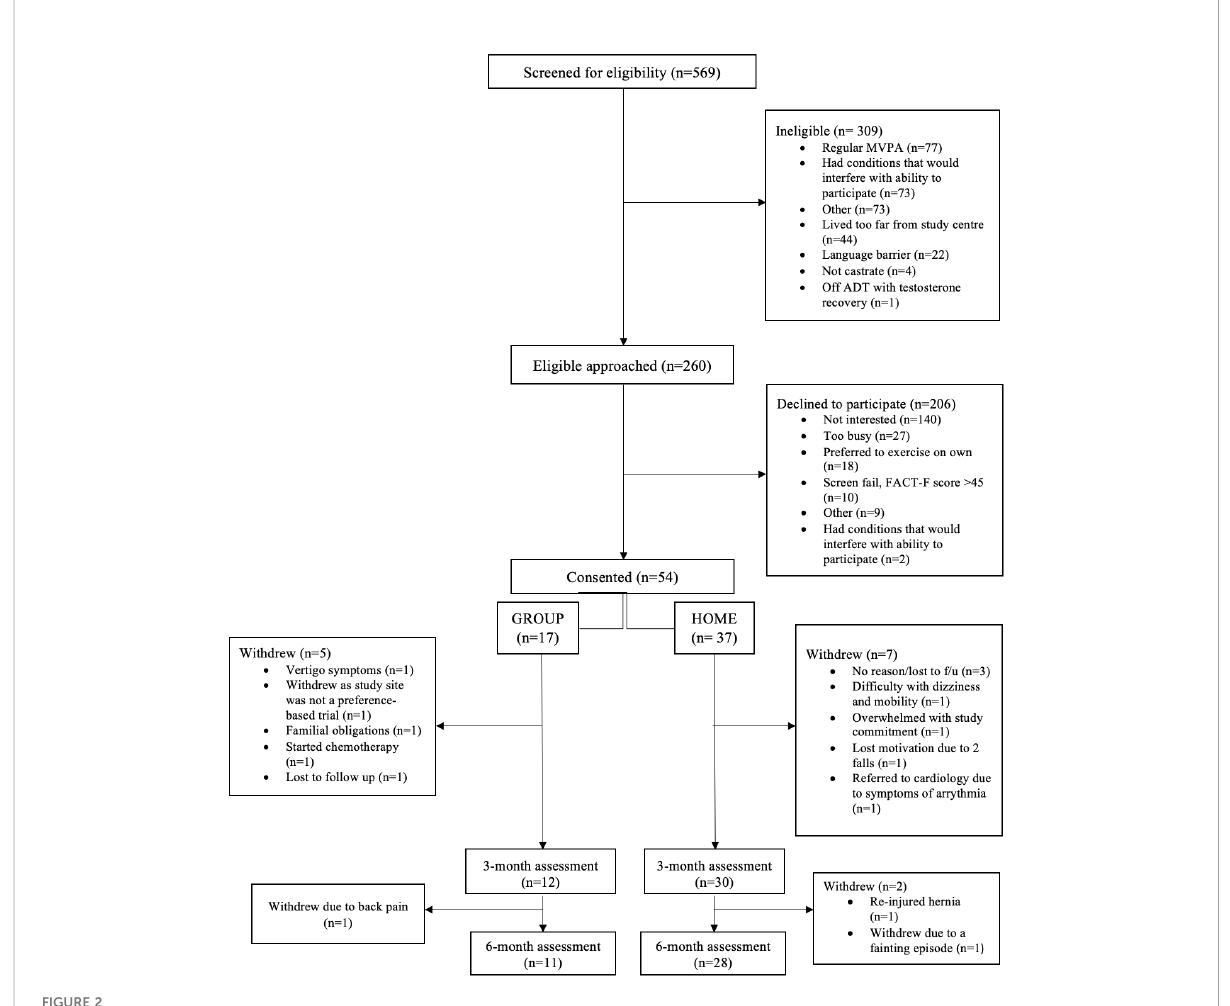
FIGURE 2 Flow diagram of study